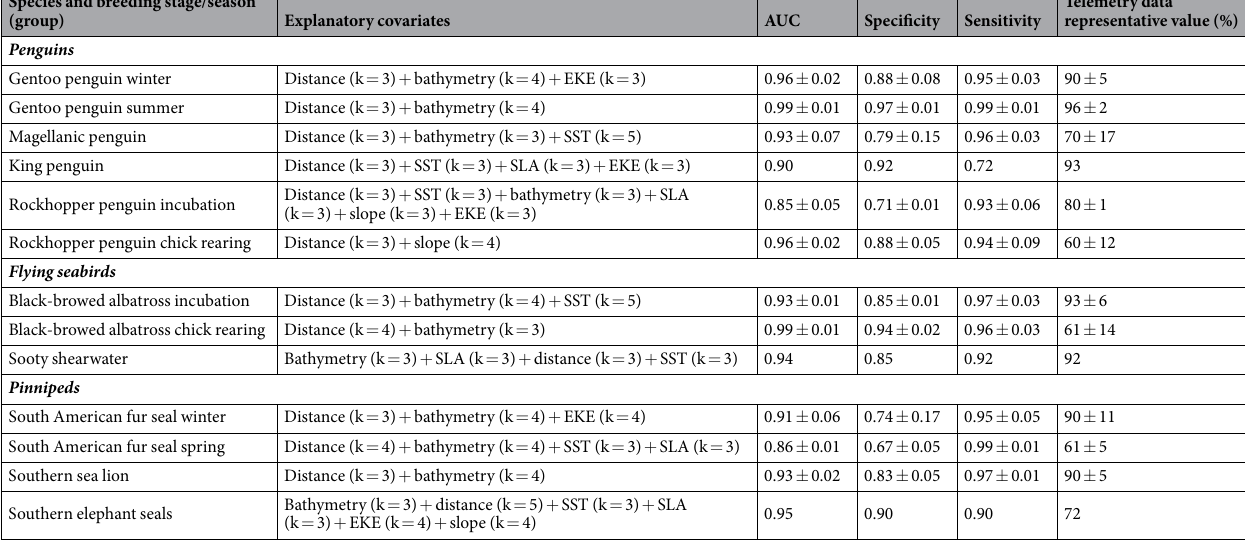
Table 2. Summary of Generalized Additive Models used for predictions, the explanatory covariates and the number of knots used in the final model. Also presented, are the area under the curve (AUC), specificity and sensitivity values associated with the final models used for predictions. Finally, the representative values associated with biotelemetry and biologging data are presented (see methods for details – if multiple colonies were tracked, mean values are reported). High representative values > 75 (%) indicate that biotelemetry and biologging data were considered sufficiently representative of the expected space use if more individuals were tracked. SST = Sea Surface Temperature, SLA = Sea Level Anomaly, EKE = Eddy Kinetic Energy. All values are mean ±